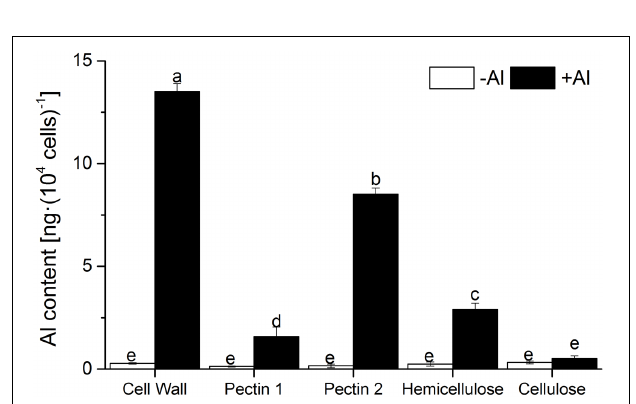
FIGURE 1 | Accumulation of Al in RBCs and root segments. (A) Al concentration in root segments (0–2.5 mm, 2.5–5.0 mm, and 5.0–10.0 mm); (B) Al concentration in RBCs and root segments (0–10.0 mm); (C) Al content in one root apex (0–2.5 mm) and one set of RBCs around the apex. Seedlings were treated with 0 or 1.0 mM AlCl 3 (in 0.5 mM CaCl 2 , pH 4.0) mist for 24 h. Al in RBCs and root segments was extracted in 2 M HCl and Al content was determined by ICP-AES. Bars represent standard error ( n = 3). Different lowercase letters indicate significant differences at p < 0.05. DW, dry weight.